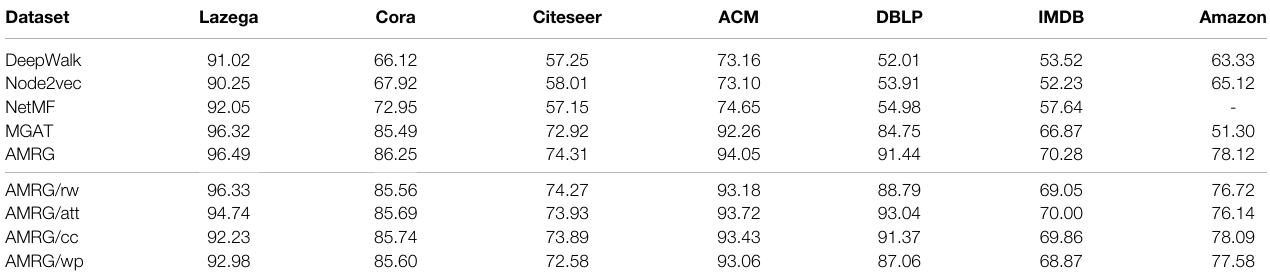
TABLE 4 | Node classi fi cation Accuracy ( % ) (bold: Best). Dataset